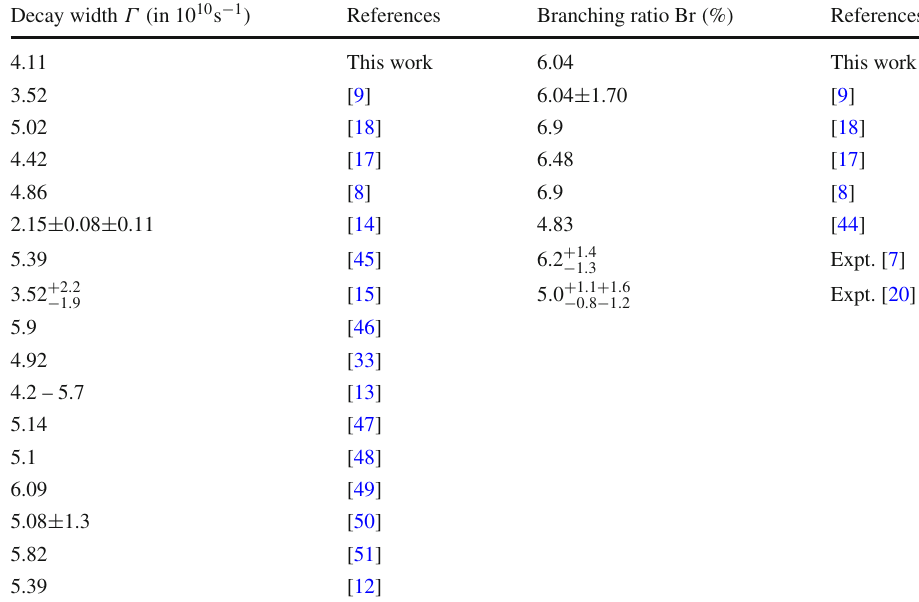
Table 4 Comparison of theoretical predictions for the Λ → Λ (cid:3) ¯ ν semileptonic b c decay parameters with available experimental